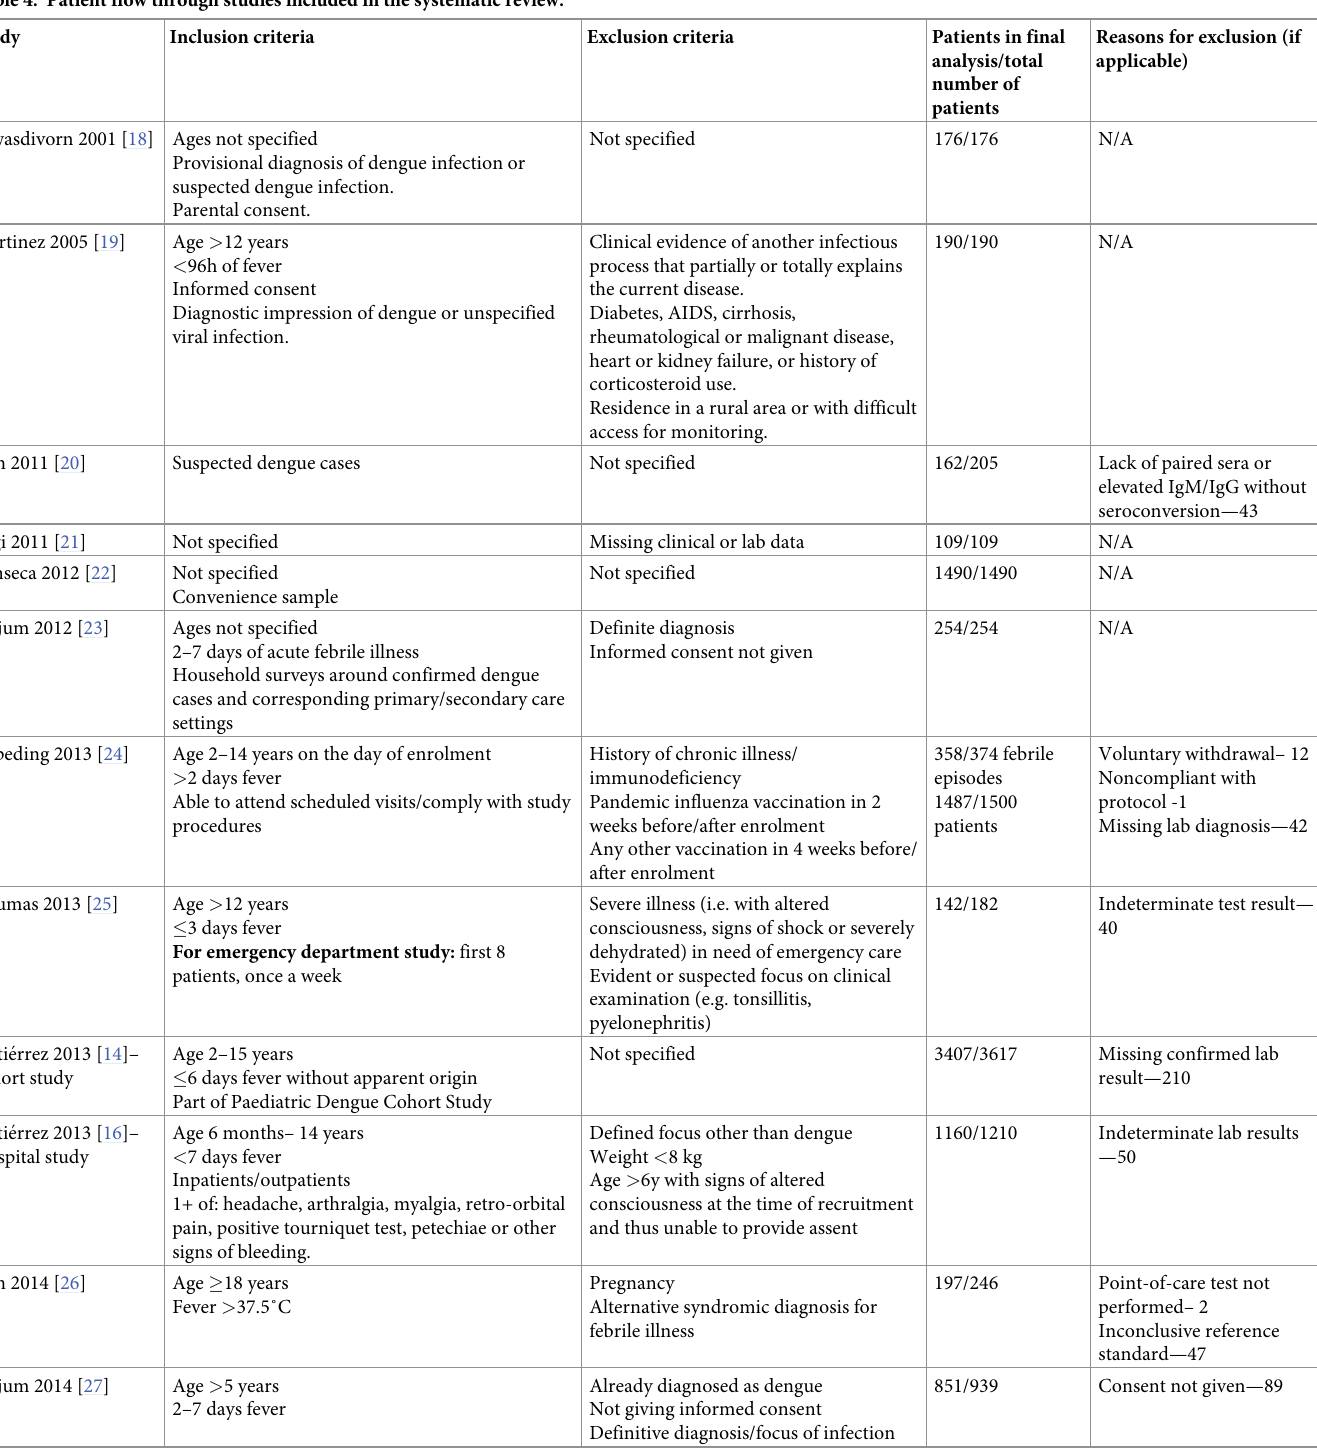
Table 4. Patient flow through studies included in the systematic